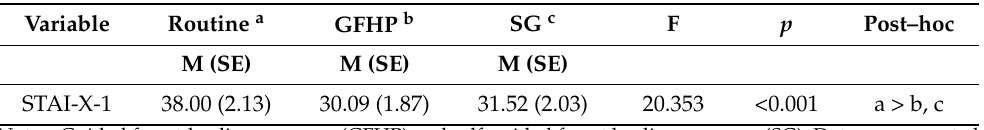
Table 3. The results of the one-way repeated measures of ANOVA of State-Trait Anxiety Inventory-X1 (STAI-X1)